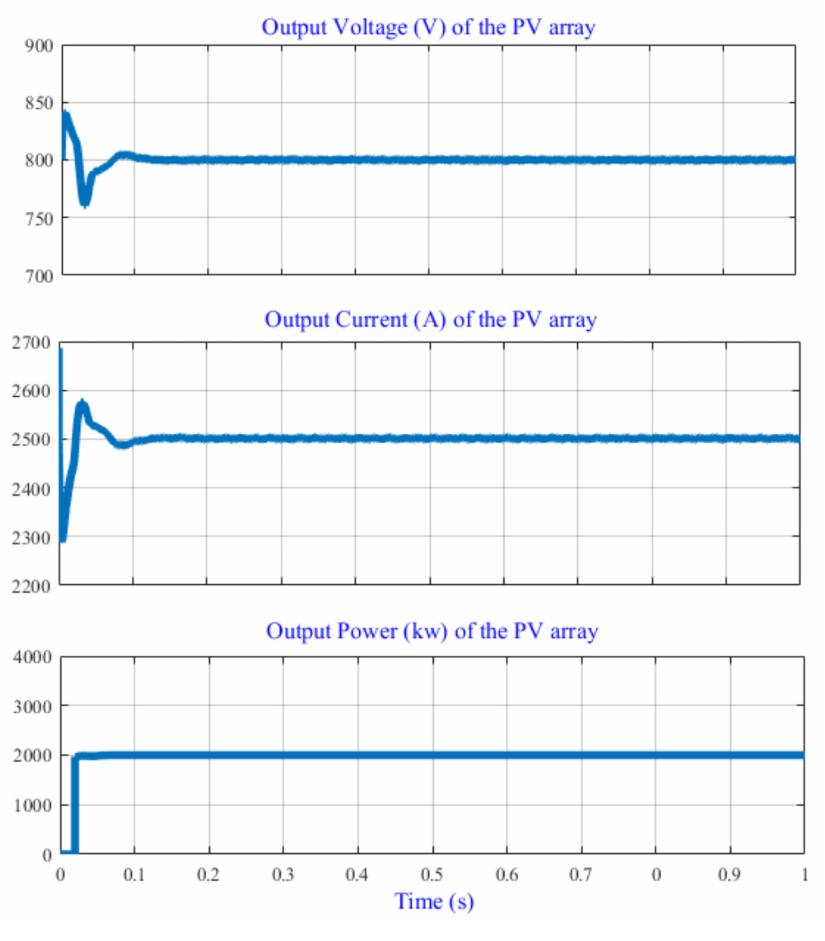
Figure 11. The PVPP array output at STC.